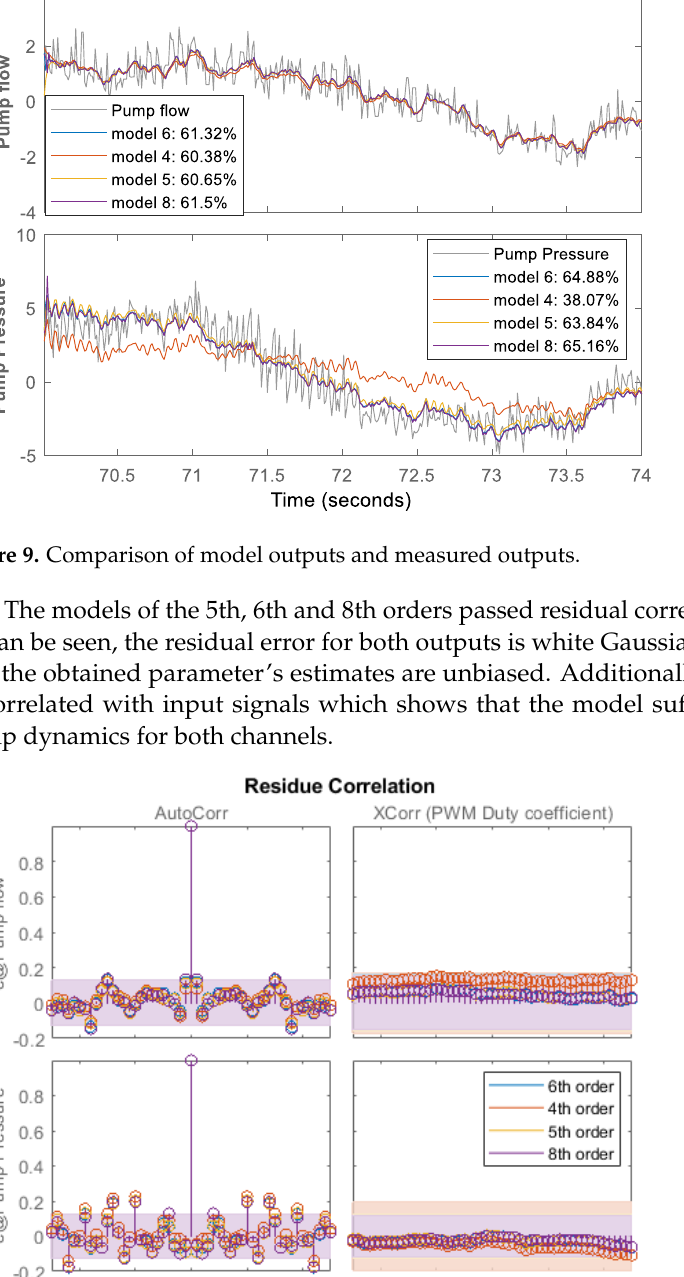
Figure 9. Comparison of model outputs and measured outputs.